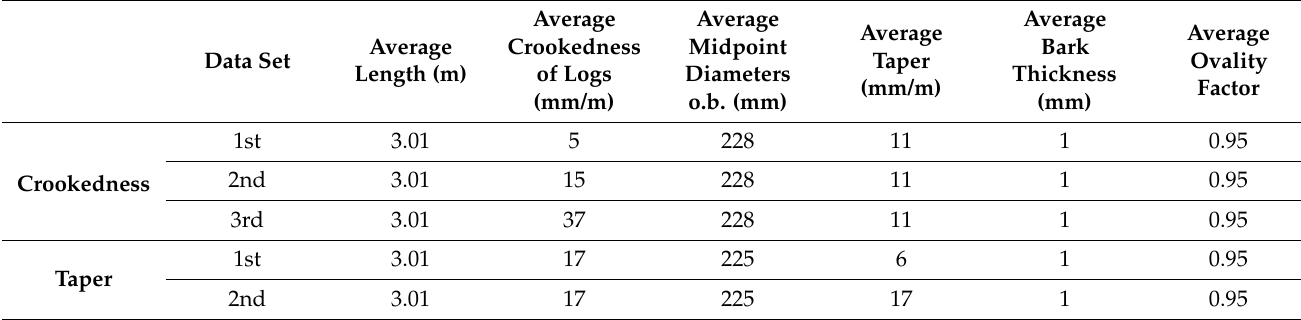
Table 1. Average values of the parameters of each data set to analyze the influence of different crookedness and taper degrees on the stack volume.